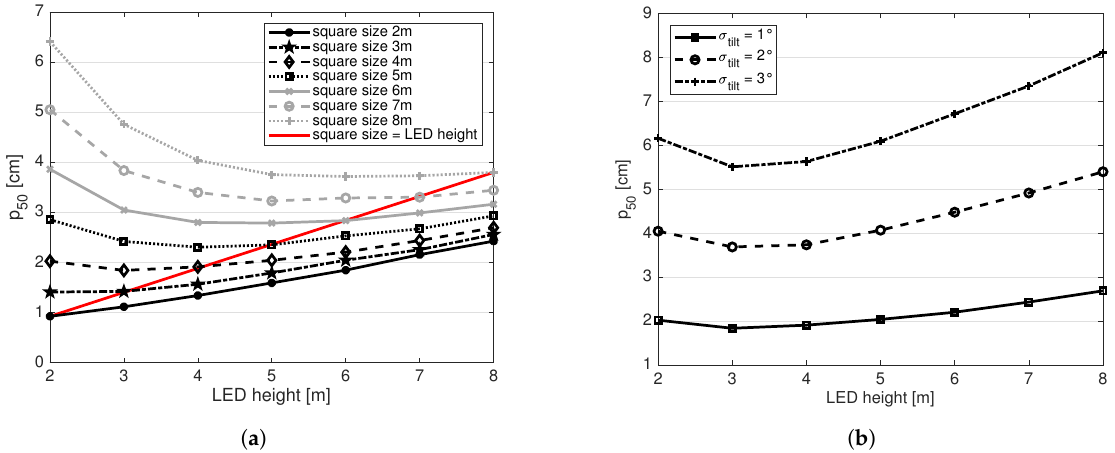
Figure 6. Induced median error due to LED tilt for different LED square sizes, heights, and tilts. ( a ) Induced median error for square side lengths between 2 and 8 m, as a function of LED height, for a σ tilt value of 1°; ( b ) Induced median error for a 4 × 4 m LED square, as a function of LED height for three σ tilt